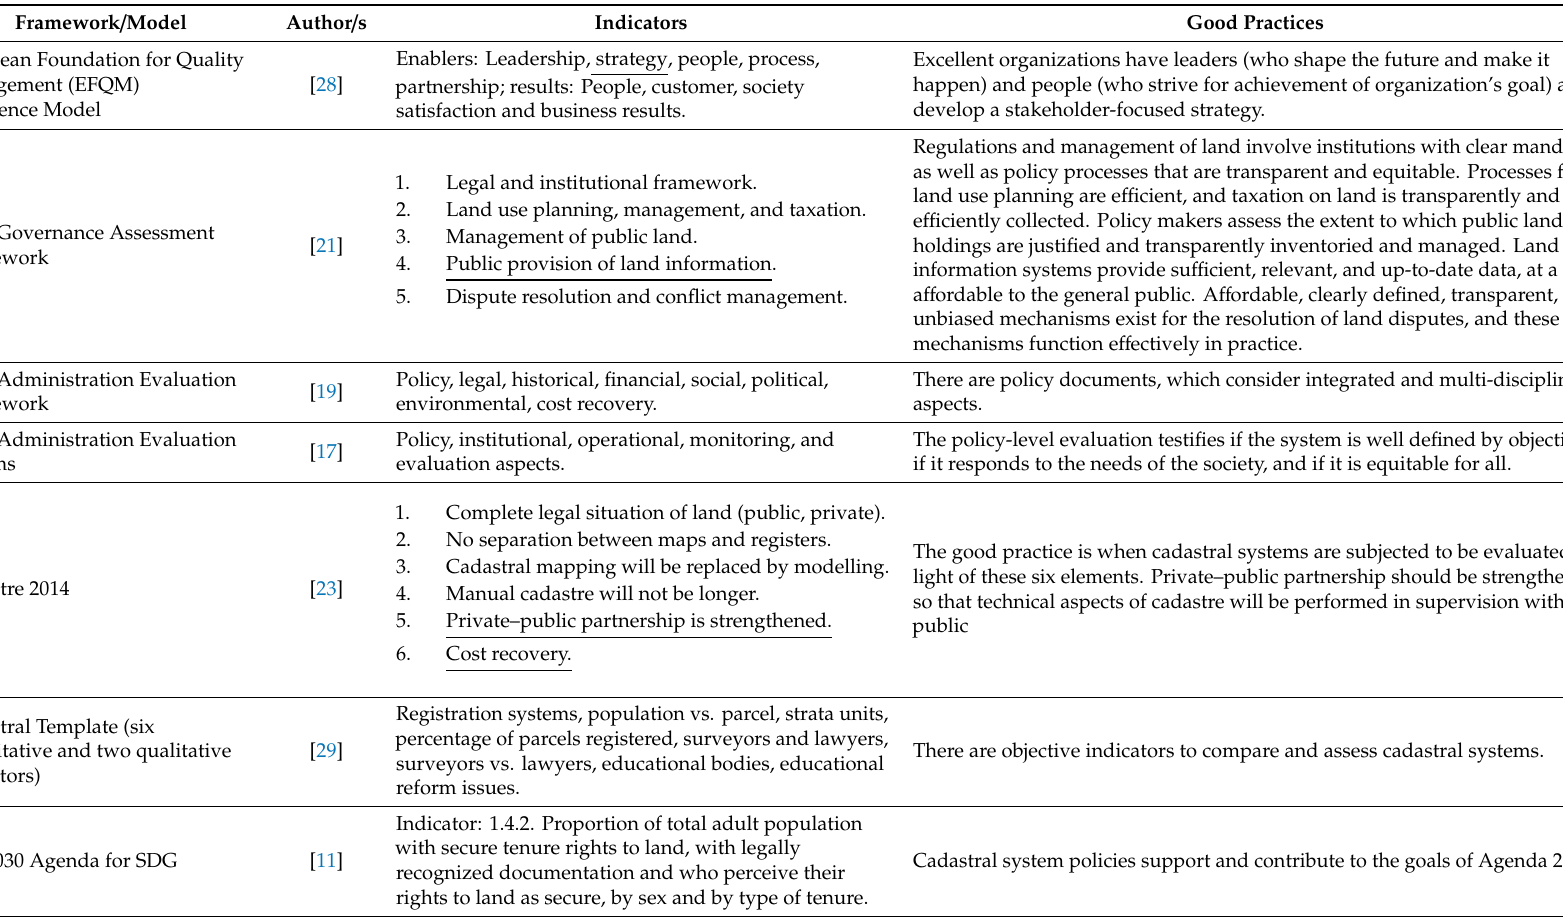
Table 1. Benchmark frameworks for urban cadastral